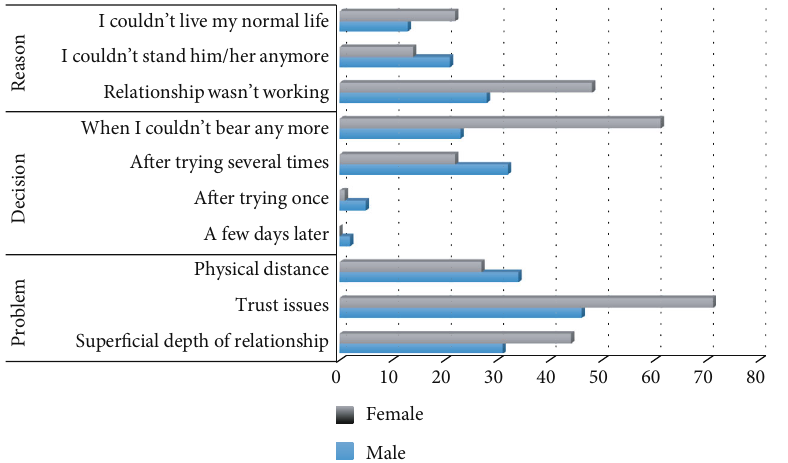
Figure 3: Dysfunctional relationship.